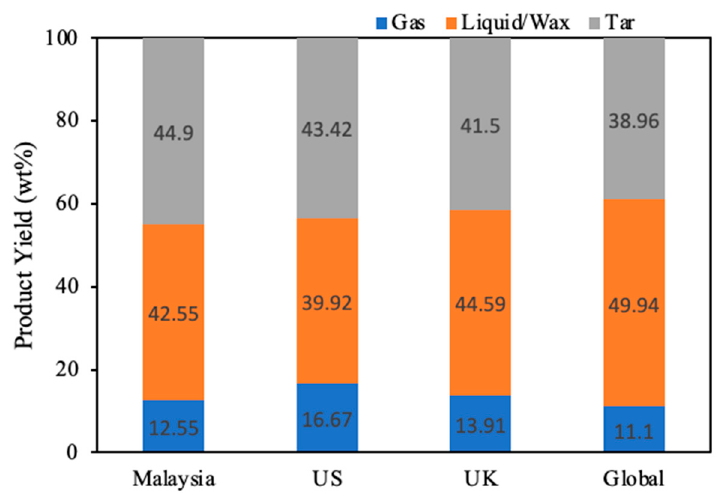
Figure 3. The product distribution of thermal pyrolysis of mixed plastic wastes at 500